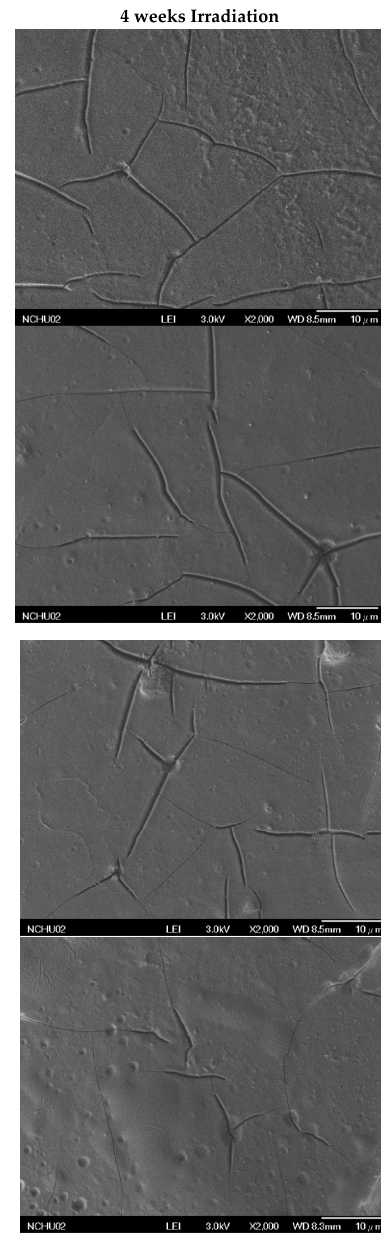
Figure 10. SEM images of g-PBCT and various weight ratio of g-PBCT/m-PPZn composites before and after 4 weeks UV irradiation times.